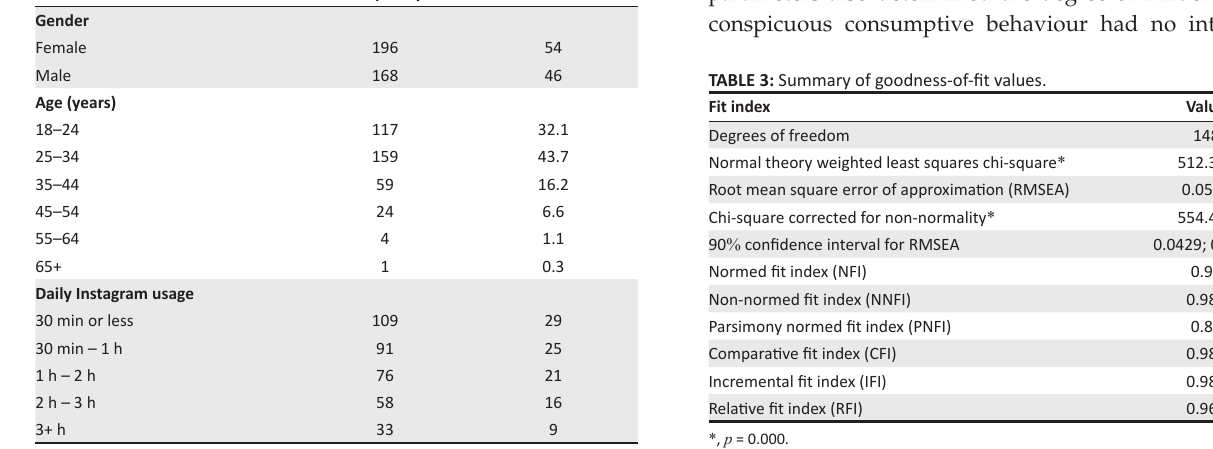
TABLE 2: Demographic information of respondents. Measure